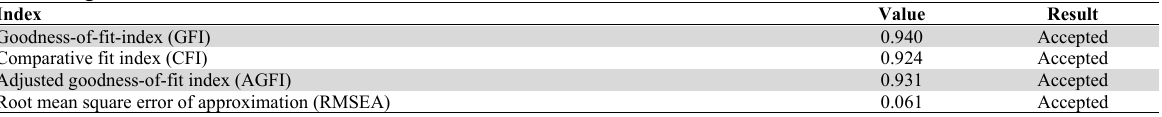
Results of goodness-of-fit